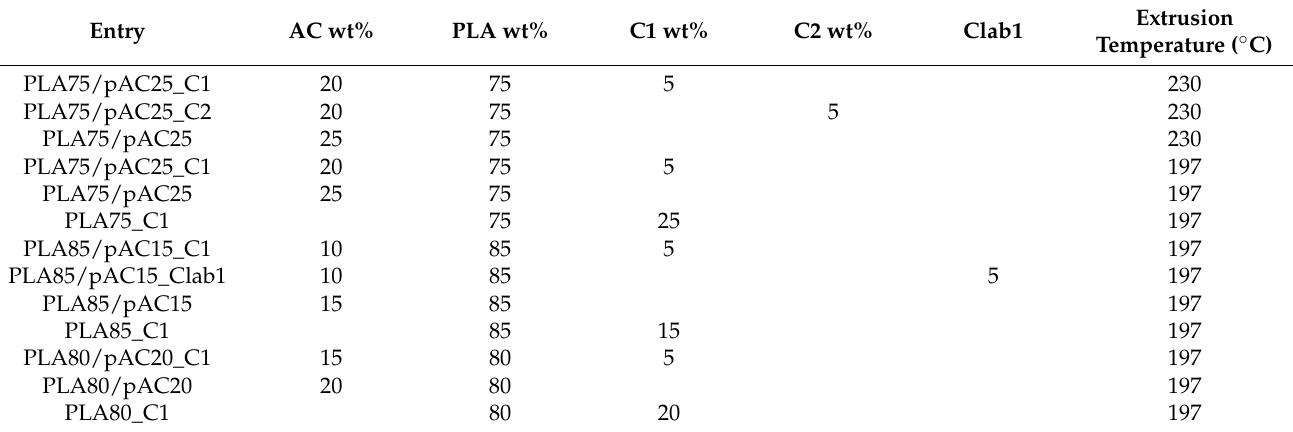
Table 6. Composition wt% of the prepared